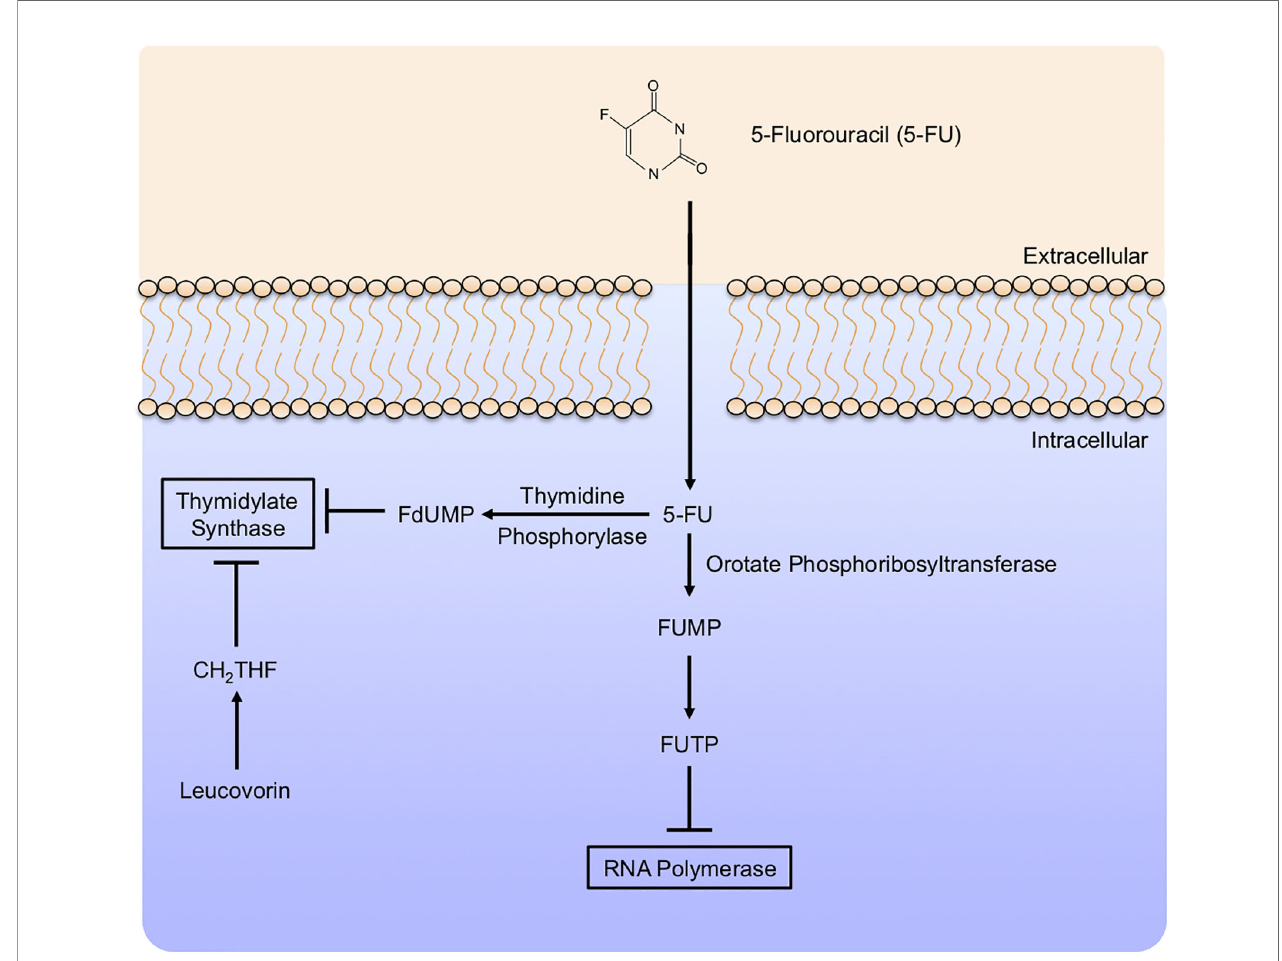
FIGURE 7 | 5-Fluorouracil mechanism of action. 5-Fluorouracil (5-FU) enters target cells in a similar manner to uracil, mainly by facilitated transport. Like Gemcitabine, 5-Fluorouracil (5-FU) is modi fi ed extensively in the cytoplasm. This includes conversion to Fluorodeoxyuridine monophosphate (FdUMP) by Thymidine Phosphorylase, inhibiting Thymidylate Synthase and potentiated by the addition of Leucovorin. In a parallel mechanism, 5-FU can be further modi fi ed to Fluorodeoxyuridine triphosphate, which subsequently inhibits RNA